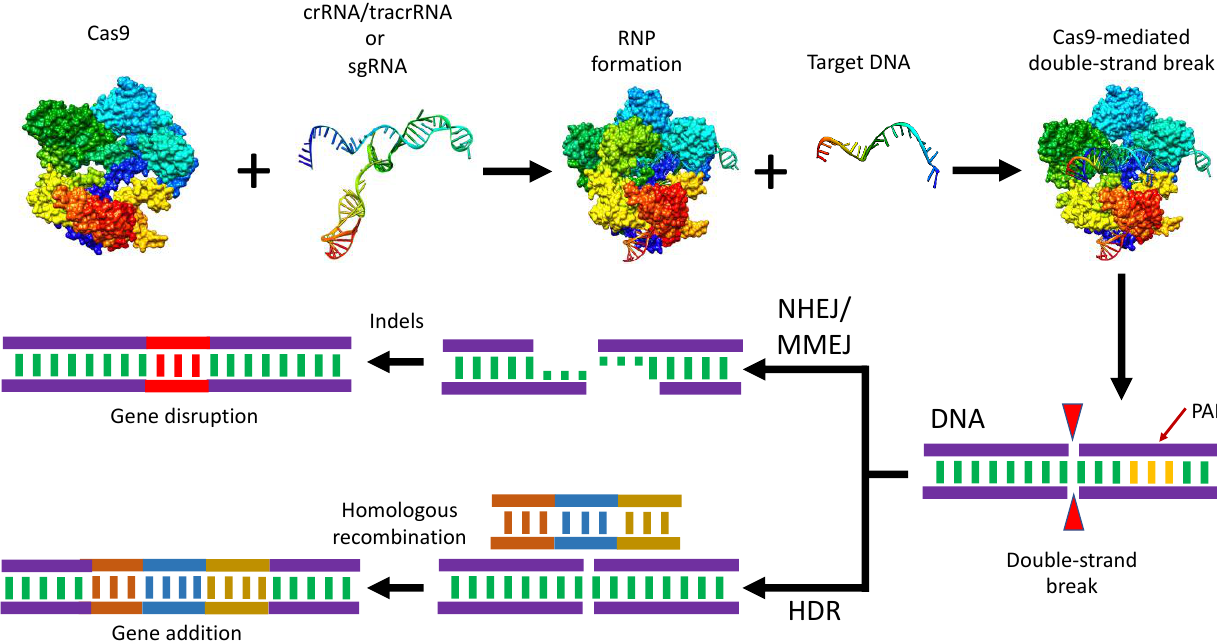
Figure 2. Multiple genomic modifications followed by cleavage of target DNA by CRISPR/Cas9. At DNA breaks, due to some mistakes in DNA repair by the endogenous NHEJ or MMEJ pathways, variable-length insertions and/or deletions (indels) can be formed. Alternatively, a DNA repair template created through the HDR pathway creates defined insertions, deletions, or other specific modifications.